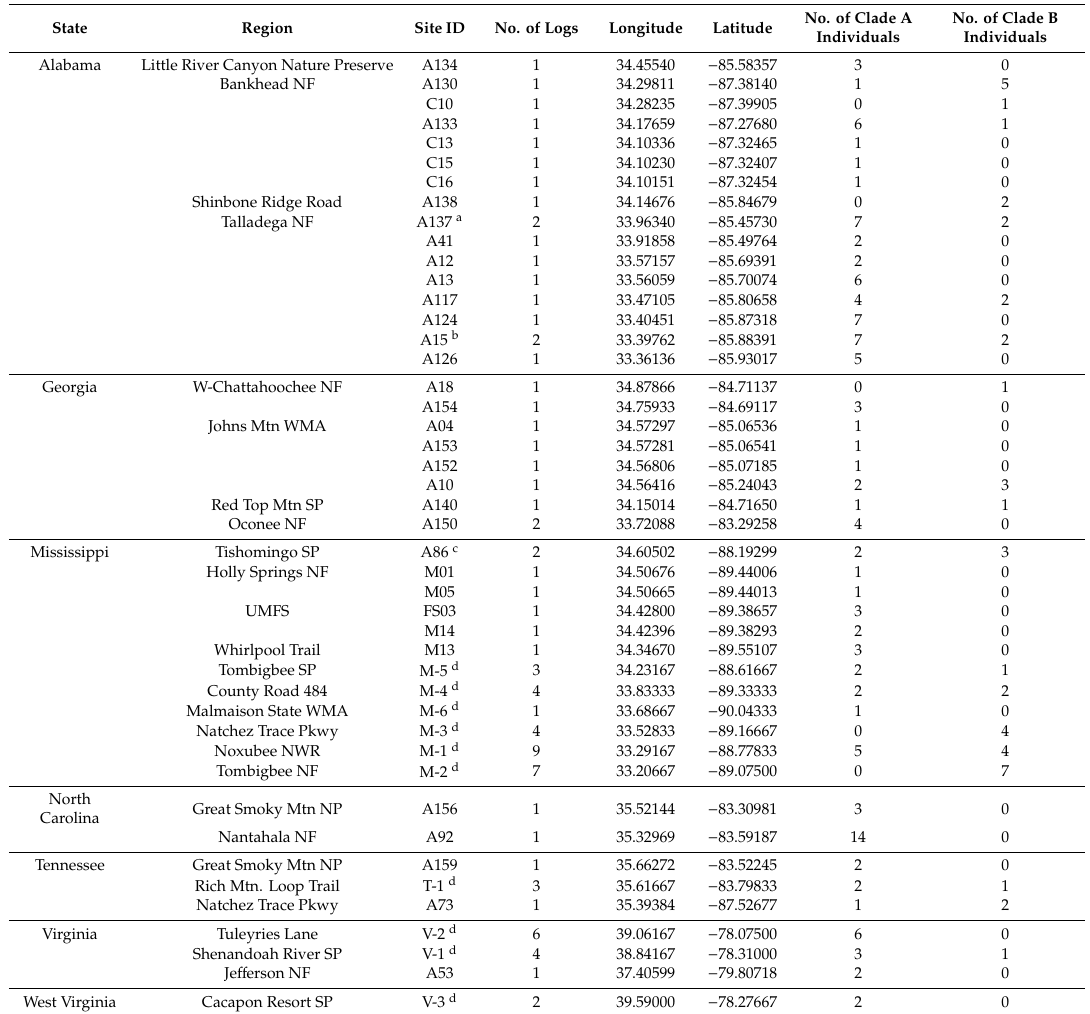
Table 2. Geographic locations from which O. disjunctus beetles were sampled, and their membership in mitochondrial DNA clades A or B. Abbreviations associated with region names are: Mountain(s), Mtn; National Forest, NF; National Park, NP; National Wildlife Refuge, NWR; Parkway, Pkwy; State Park, SP; University of Mississippi Field Station, UMFS; and Wildlife Management Area, WMA.